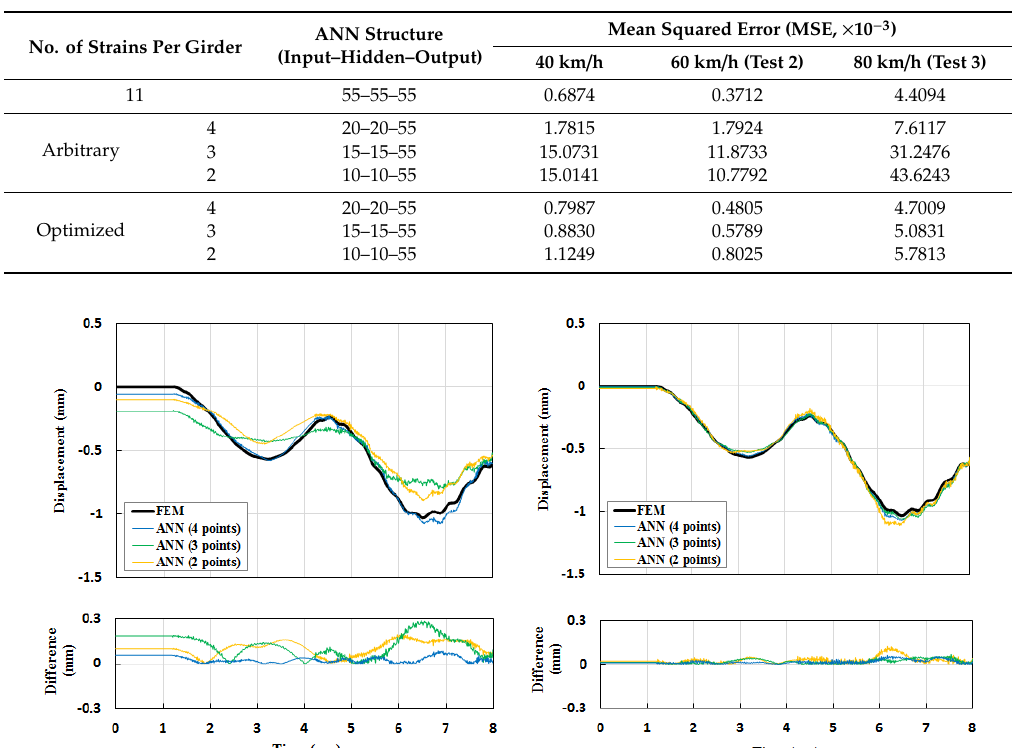
Figure 14. Overall displacements shape at t = 6.52 s (max. displacement) for the 40 km/h test dataset. ( b ) Strains at the optimized locations Figure 15. Displacements over time at center girder for 60 km/h test dataset.